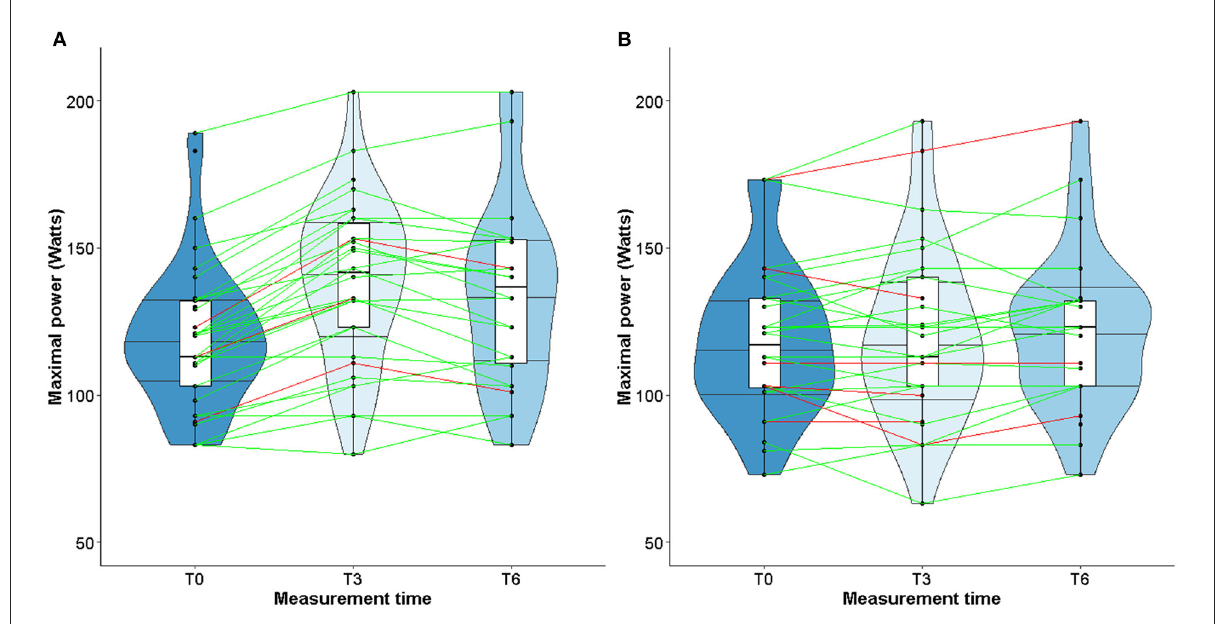
FIGURE3 Violin plot for evolution peak VO 2 in TG (A) and CG (B) .